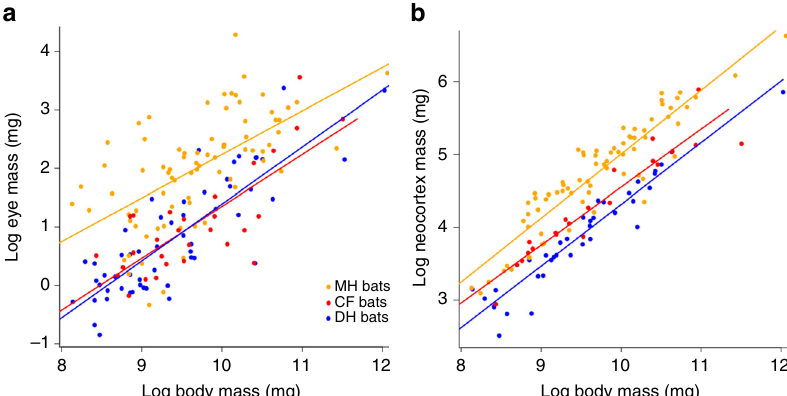
Fig. 4 Phylogenetically informed linear regressions of eye mass and neocortex on body mass by call type. Phylogenetic generalized least square models showing the regressions of log-transformed a eye mass ( N = 162) and b neocortex ( N = 162) on body mass while accounting for the phylogenetic non- independence between data points. The calls of laryngeal echolocating bats were categorized as (i) constant frequency (CF), (ii) multi-harmonic calls (MH), (iii) frequency modulated calls dominated by the fundamental harmonic (DH) and are shown separately on the plots